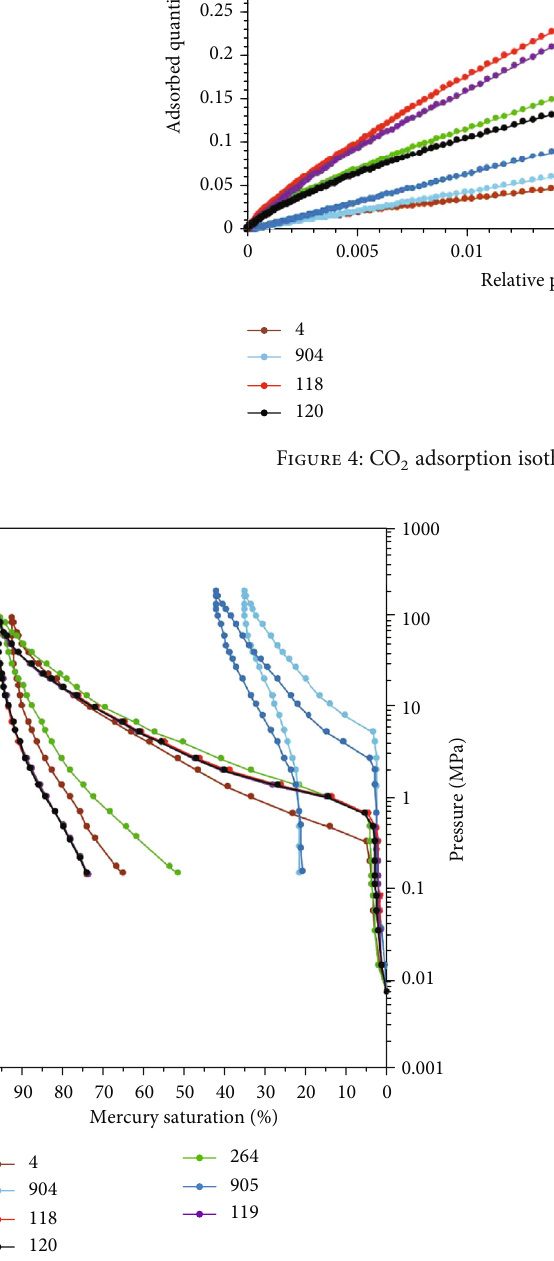
Figure 5: Mercury intrusion and extrusion curves for the seven